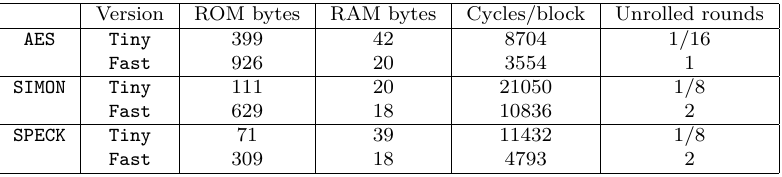
Table 2: Our Implementation of blockciphers on RL78.